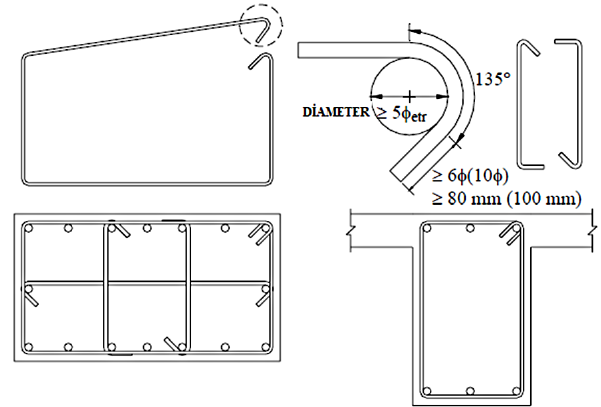
Figure 12. Stirrup hooks designed according to earthquake code (TEC, 2007). Making stirrup hooks with 90 ◦ angles is